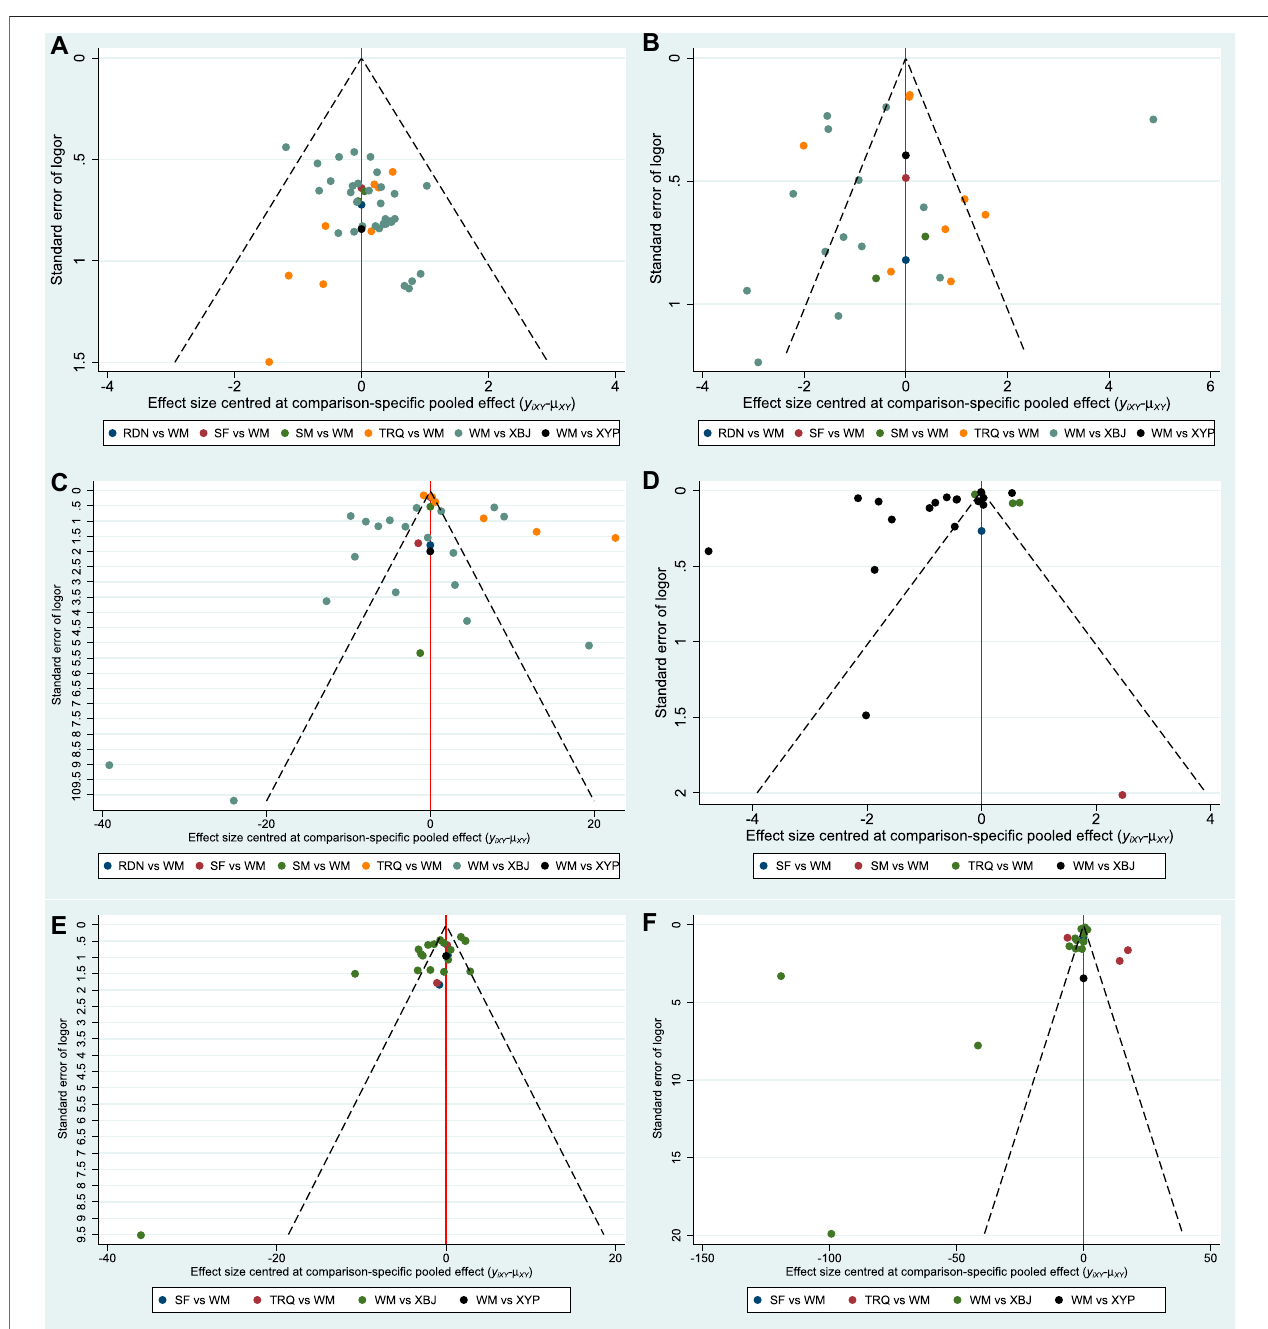
FIGURE 7 | Funnel plot. (A) Clinical effective rate; (B) the level of WBC; (C) the level of CRP; (D) the level of PCT; (E) ICU length of stay; and (F) the time of mechanical ventilation.